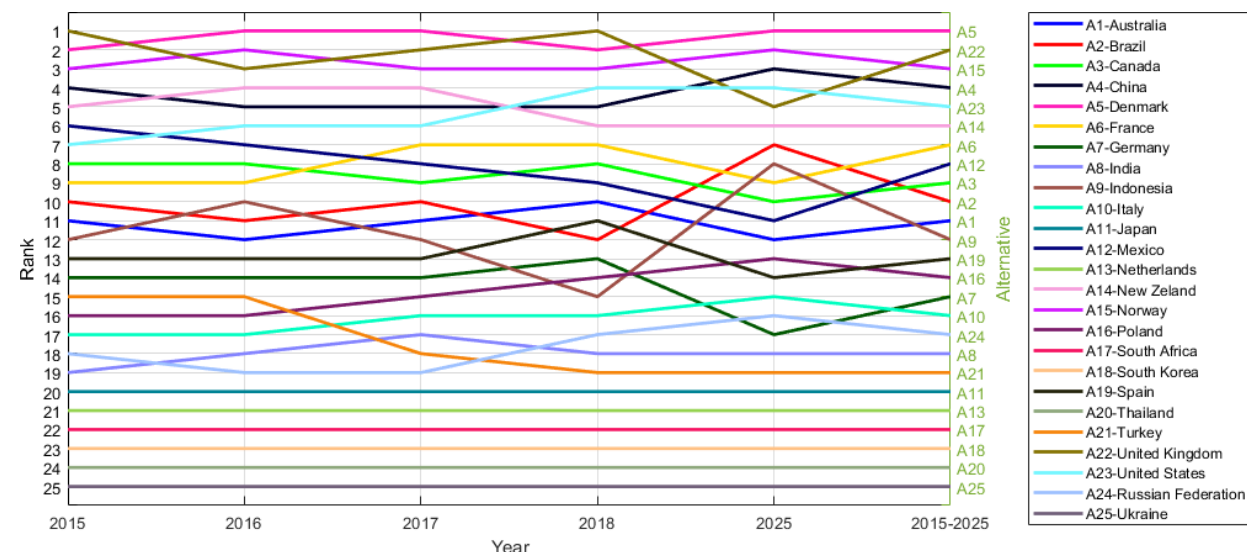
Figure 4. Variability of NEAT F-PROMETHEE II rankings in subsequent periods.